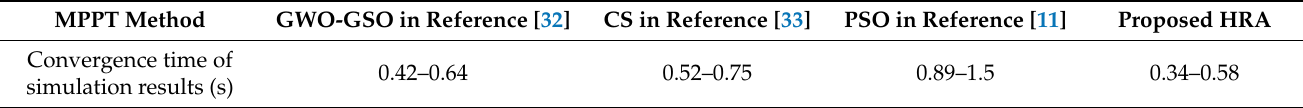
Table 5. Comparison of the simulation results of different